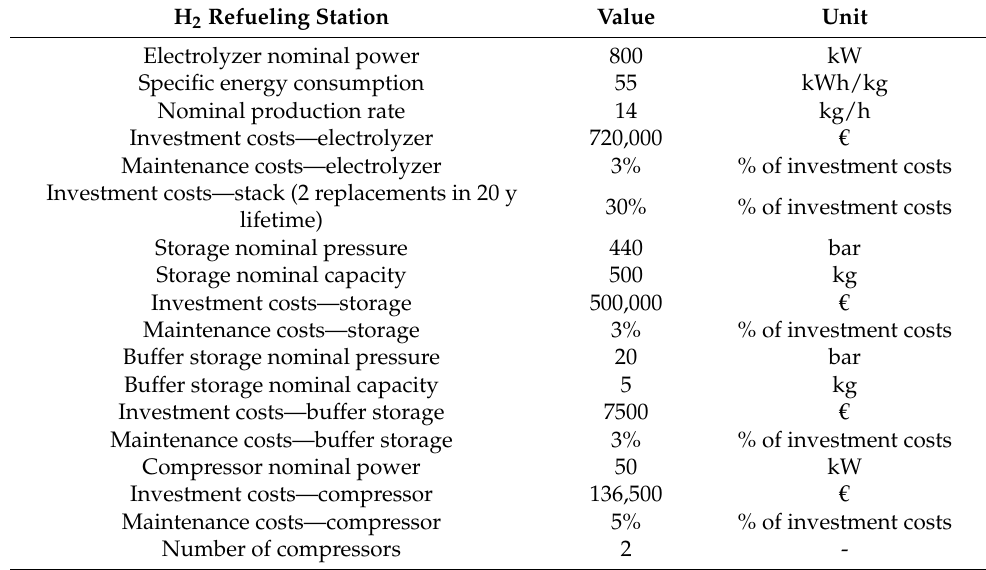
Table 9. Parameters set for hydrogen costs